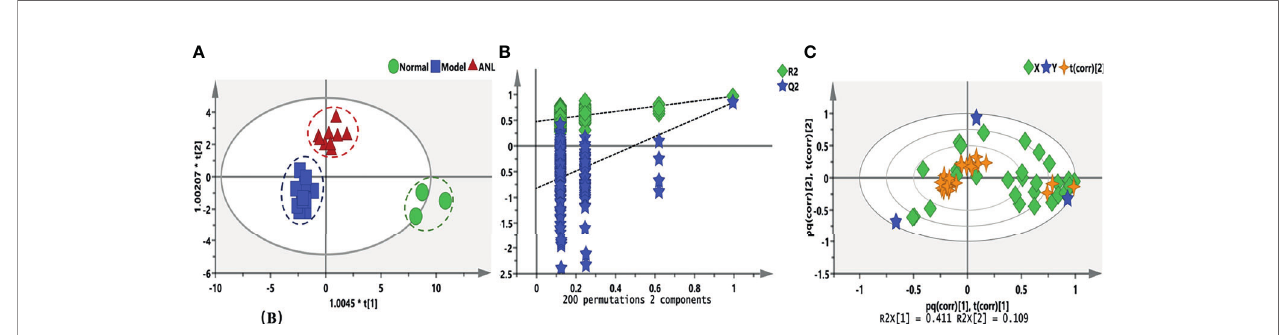
FIGURE 3 | The eicosanoids metabolic pro fi les among different treatments. (A) OPLS-DA score plots of three groups. (B) Random permutation test with 200 iterations. (C) The correlation bioplot of